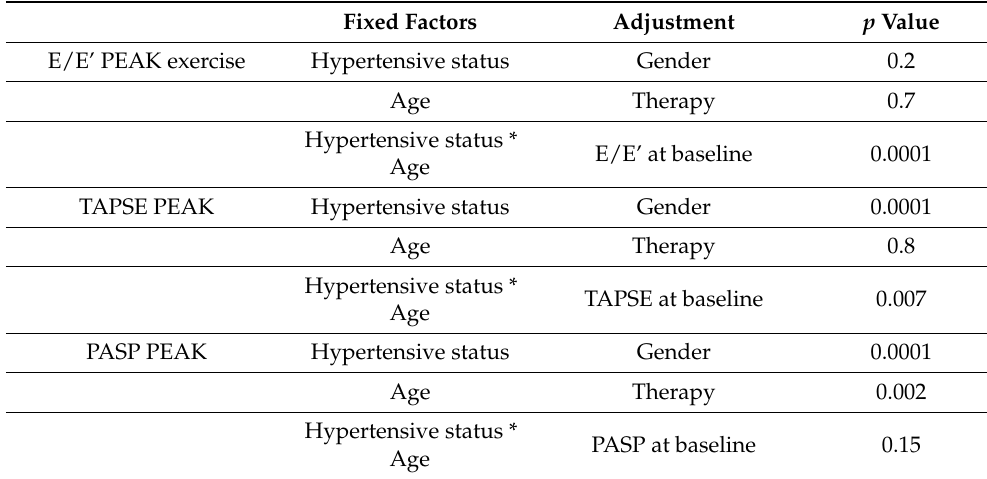
Table 7. Evaluation of hemodynamic parameters at peak exercise tested by mixed